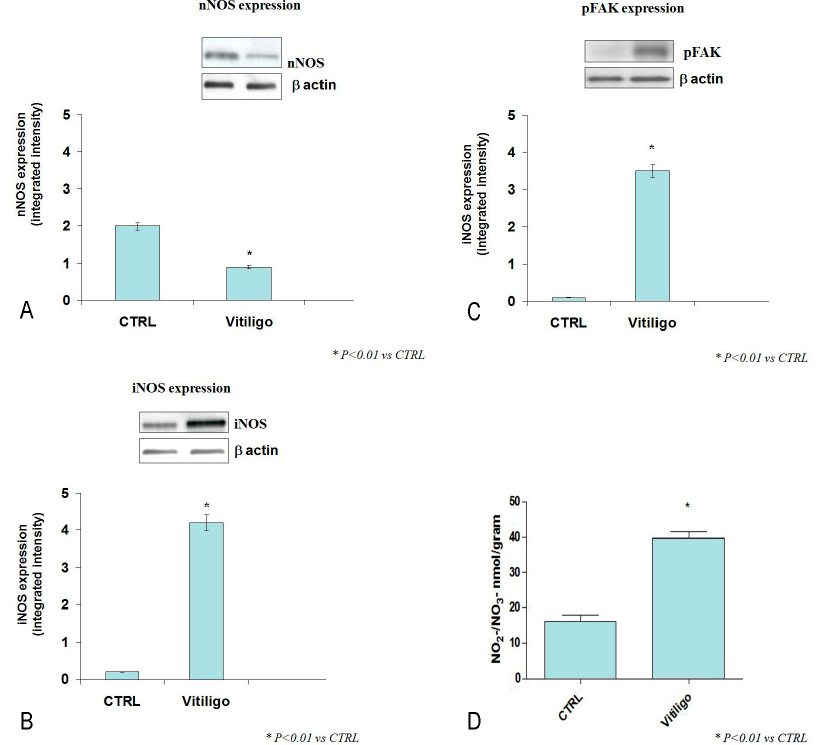
Figure 5. Western Blot Analysis of nNOS ( A ), iNOS ( B ), and pFAK ( C ) in inflammatory/lesional skin. Lesional skin showed a reduced expression of nNOS and an increased expression of iNOS and pFAK. Samples were coded and the experiments were repeated three times; NO 2 − /NO 3 − levels ( D ) in vitiligo and control samples. Vitiligo skin samples showed increased production of NO 2 − /NO 3 − levels. * p < 0.01 compared to control